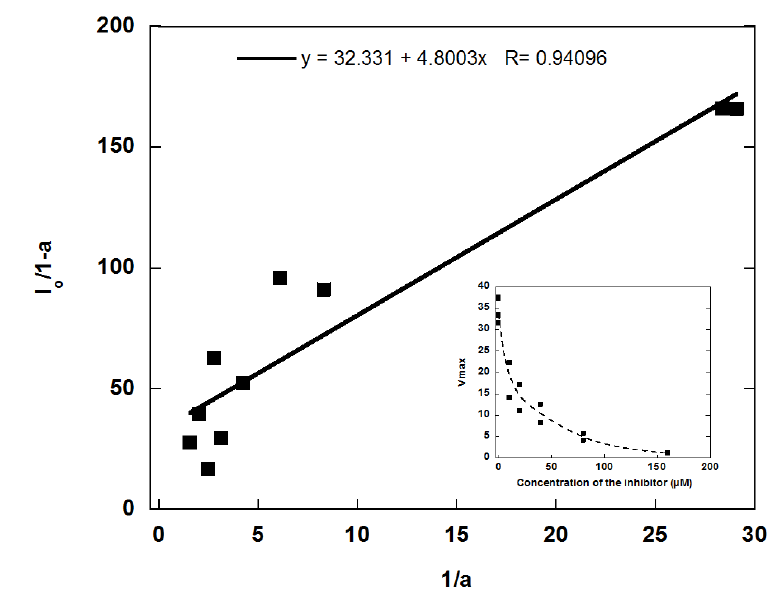
FIGURE 7. Inhibition kinetics of RVRRase activi- ty with the Ac/Dec-RVRR-CMK irreversible in- hibitor, in which a is the ratio between Vmax in the presence of the inhibitor (Vmax i ) and Vmax in the controls in the absence of the